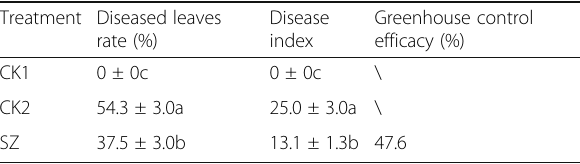
Table 3 Efficacy of strain ZSH-1 in controlling poplar anthracnose under greenhouse conditions Treatment Diseased leaves rate